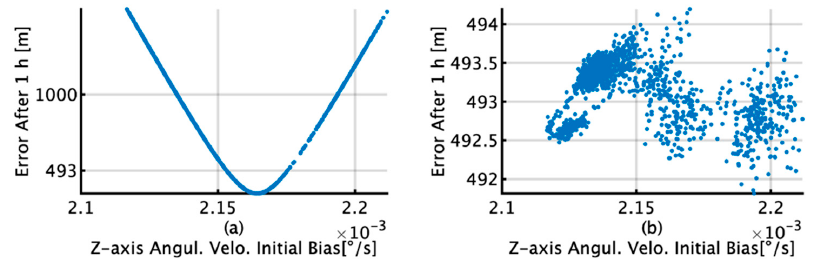
Figure 14. ( a ) Relationship between z -axis angular velocity initial bias and horizontal error after 1 h in INS/DVL; ( b ) relationship between z -axis angular velocity initial bias and horizontal error after 1 h in IDG.